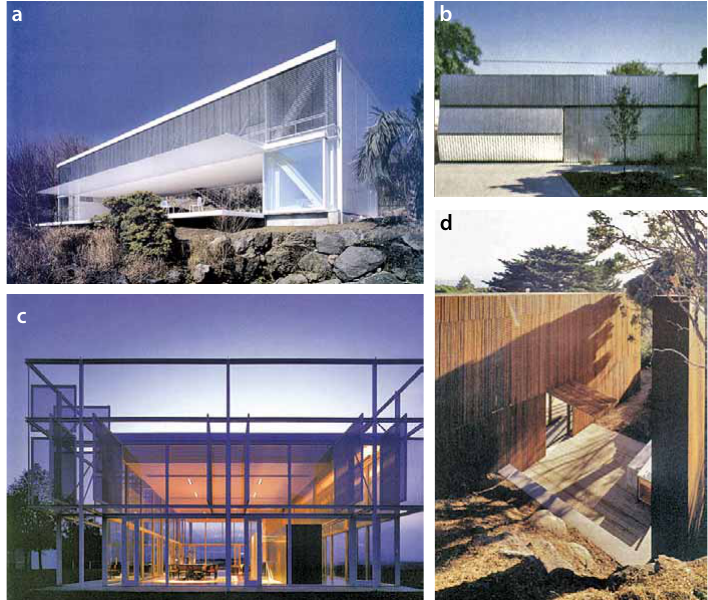
Fig. 10. Dwelling-houses,